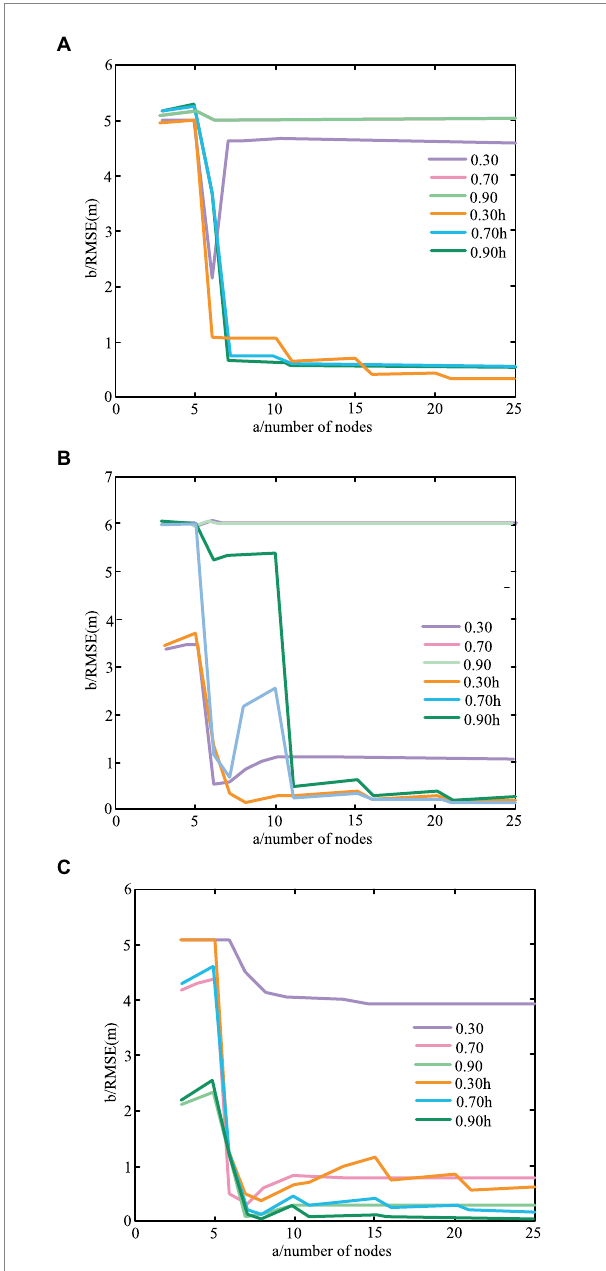
FIGURE 10 Error location results for different reflection coefficients with different values. (A) The positioning results of different reflection coefficient errors when the value is 0. (B) The positioning results of different reflection coefficient errors when the value is 0.5. (C) The positioning results of different reflection coefficient errors when the value is